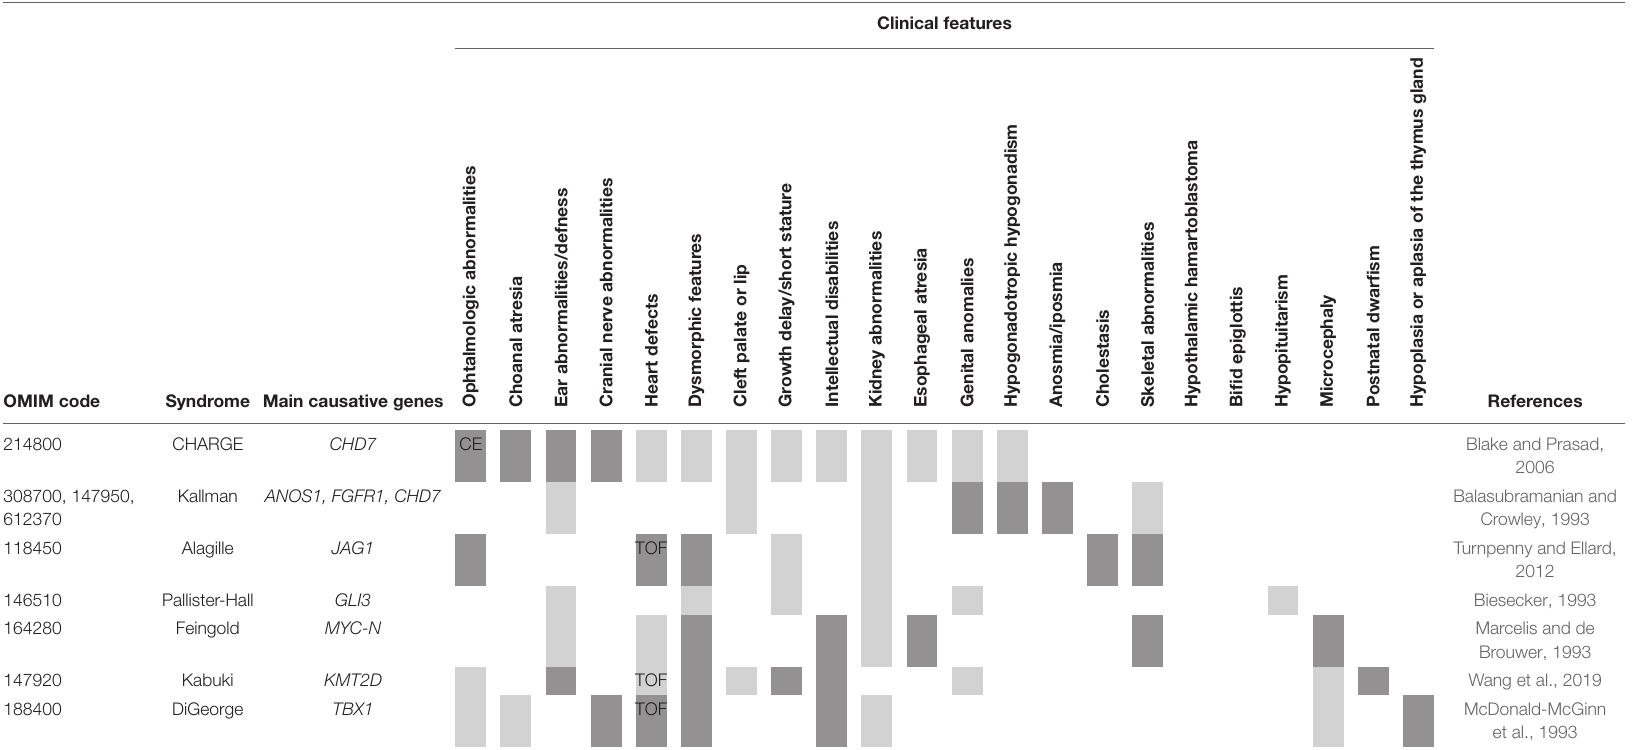
Dark gray denotes the presence of the indicated symptom in each syndrome, and white denotes its absence (major features), whereas light gray indicates that the symptom is not always present (minor features). TOF, tetralogy of Fallot; CE, coloboma of the